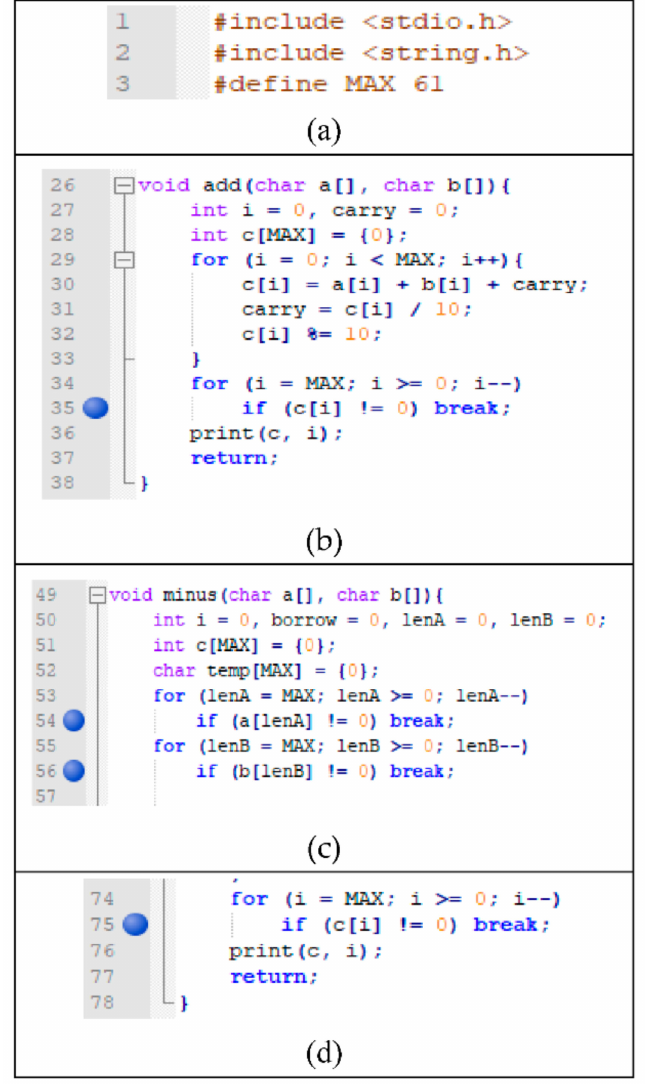
Figure 16. Example program (2), ( a ) Source code macro definition, ( b ) when the current value in the array indexed starts at 61, ( c ) The declaration of an array with MAX as the size, ( d ) When the current value in the array indexed starts at